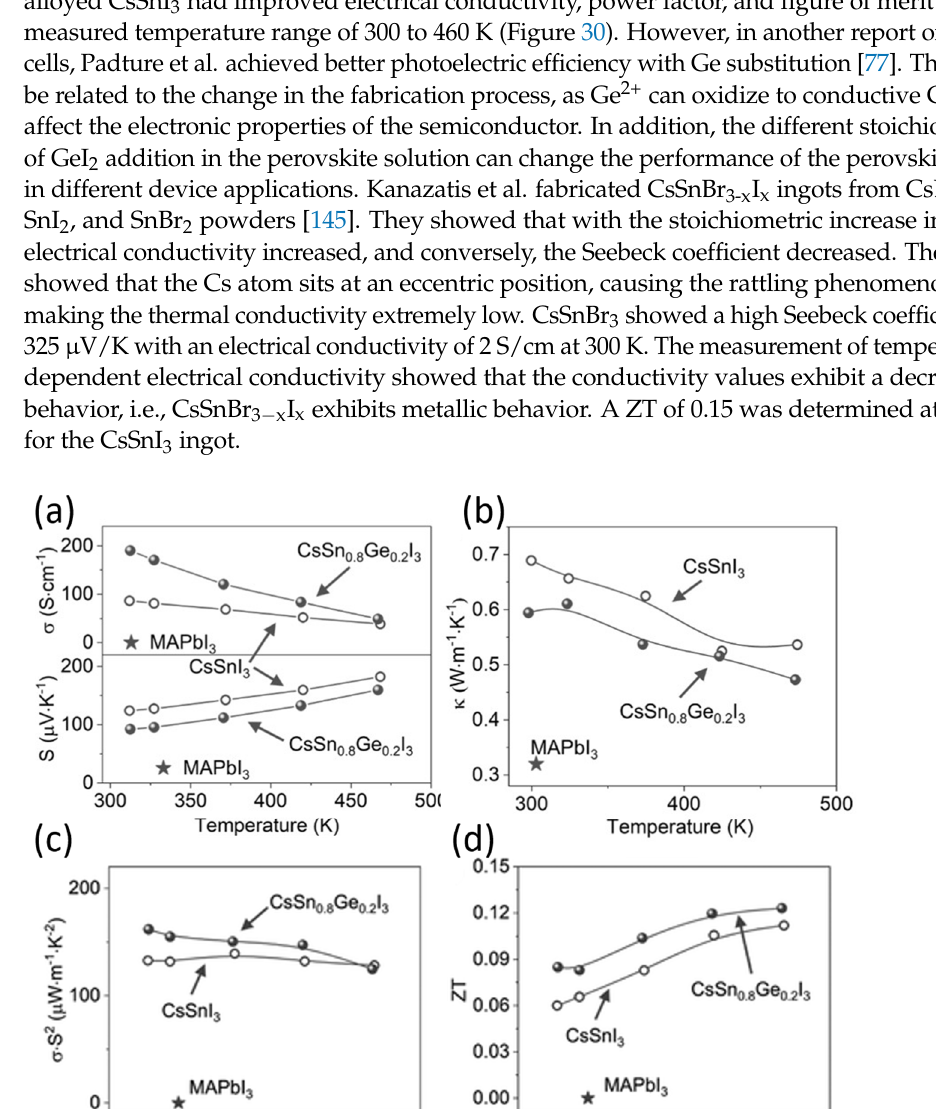
Figure 31. Thermoelectric performance of CsSnI 3-x Cl x (SnCl 2 = 1%) thin films ( a ) Temperature dependence on electrical conductivity, ( b ) Temperature dependence on Seebeck coefficient, ( c ) Temperature dependence on thermal conductivity, ( d ) Temperature dependence on the figure of merit, ( e ) Ambient air exposure time influence on charge density and mobility, ( f ) Figure of merit variation with SnCl 2 substitution. Reproduced